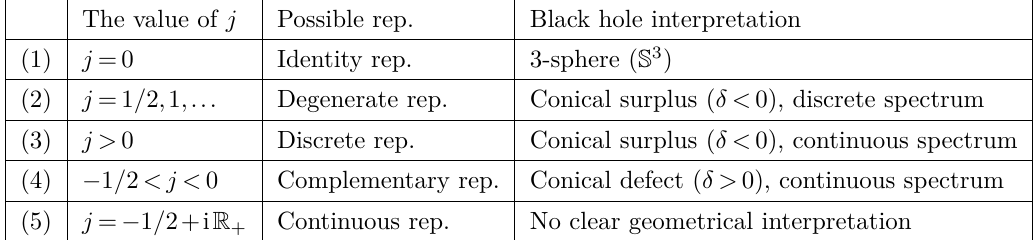
Table 1 . The possible value of j for the SU (2) representation and its dual interpretation of black hole